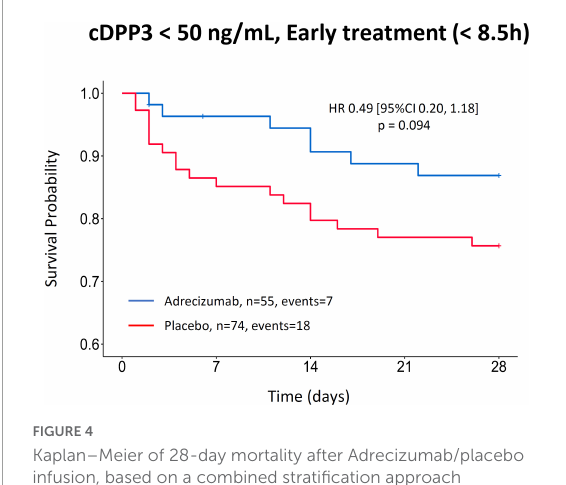
FIGURE4 Kaplan–Meier of 28-day mortality after Adrecizumab/placebo infusion, based on a combined stratification approach implementing a cDPP3 < 50 ng/mL as well as a treatment time < 8.5 h after diagnosis of shock. Both Adrecizumab dosing groups were combined. Crosses represent censored patients.